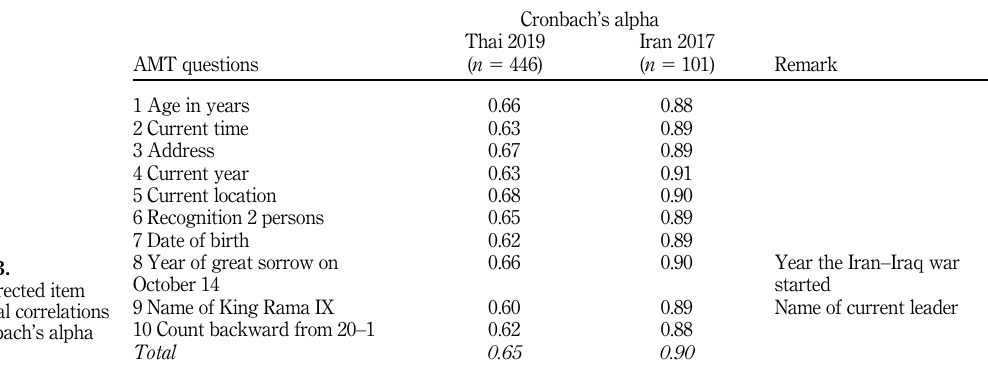
Figure 1, with the mean (SD) difference score between the percent correct as indicated by the two measures of (cid:1) 4.35 ( ± 14.06) and 95% levels of agreement of (cid:1) 31.92 and 23.21. The mean percent of AMT was higher than the mean percent of MMSE. Lin ’ s concordance correlation coefficient was rho 5 0.49 (SE 5 0.04; p < 0.001) indicating a nonchance